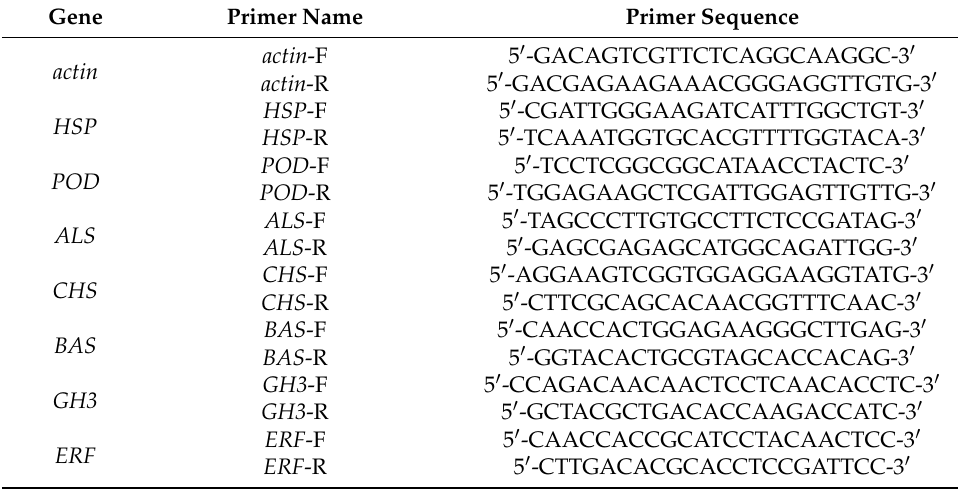
Table 3. qRT-PCR primers used in this